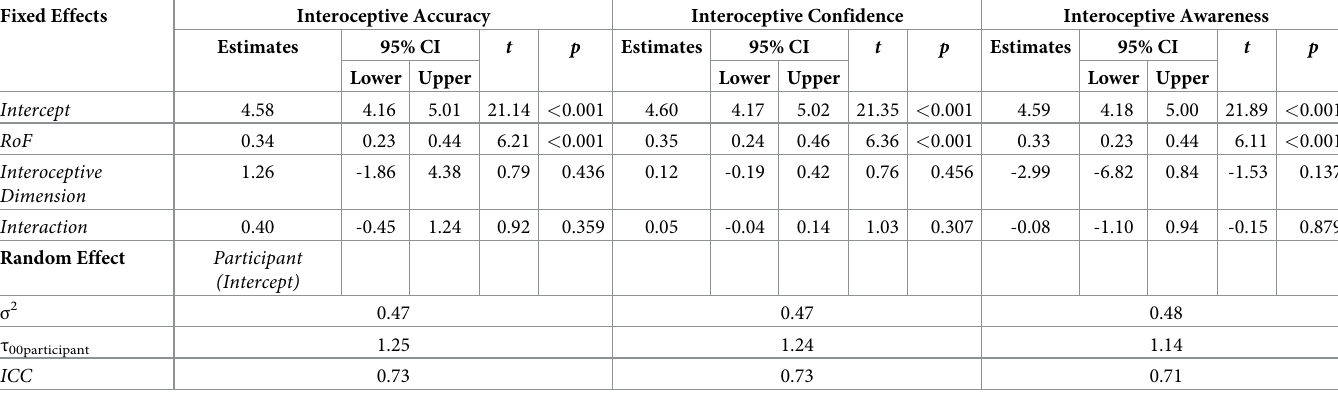
Interaction: the interaction effect between RoF and the respective interoceptive dimension, RoF: Rating of Fatigue, σ 2 : residual variance, τ 00participant : individual